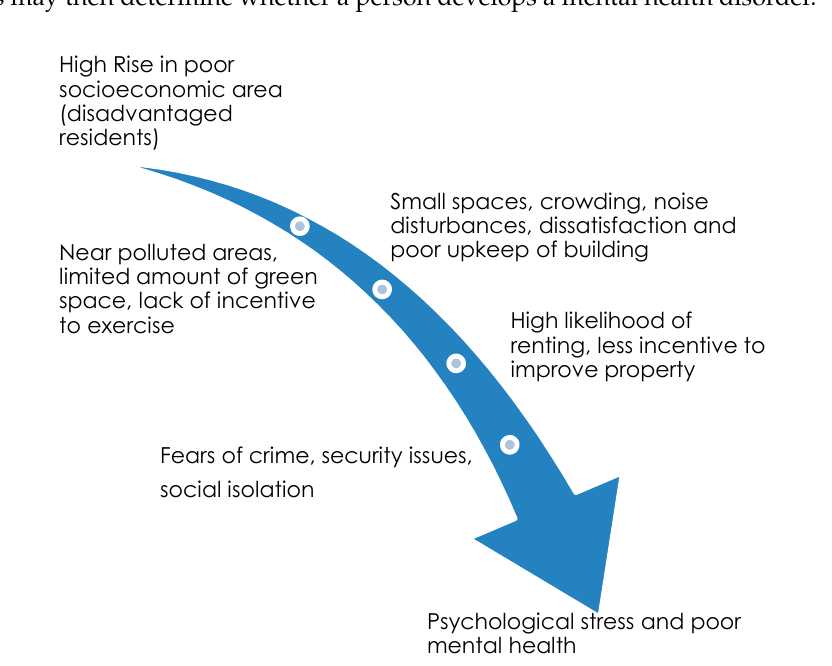
Figure 1. A possible causal sequence of high-rise apartments in poor socioeconomic areas where environmental health problems, dissatisfaction of living space, limited green space and a higher likelihood of renting may lead to social isolation, security fears and declining mental health status.